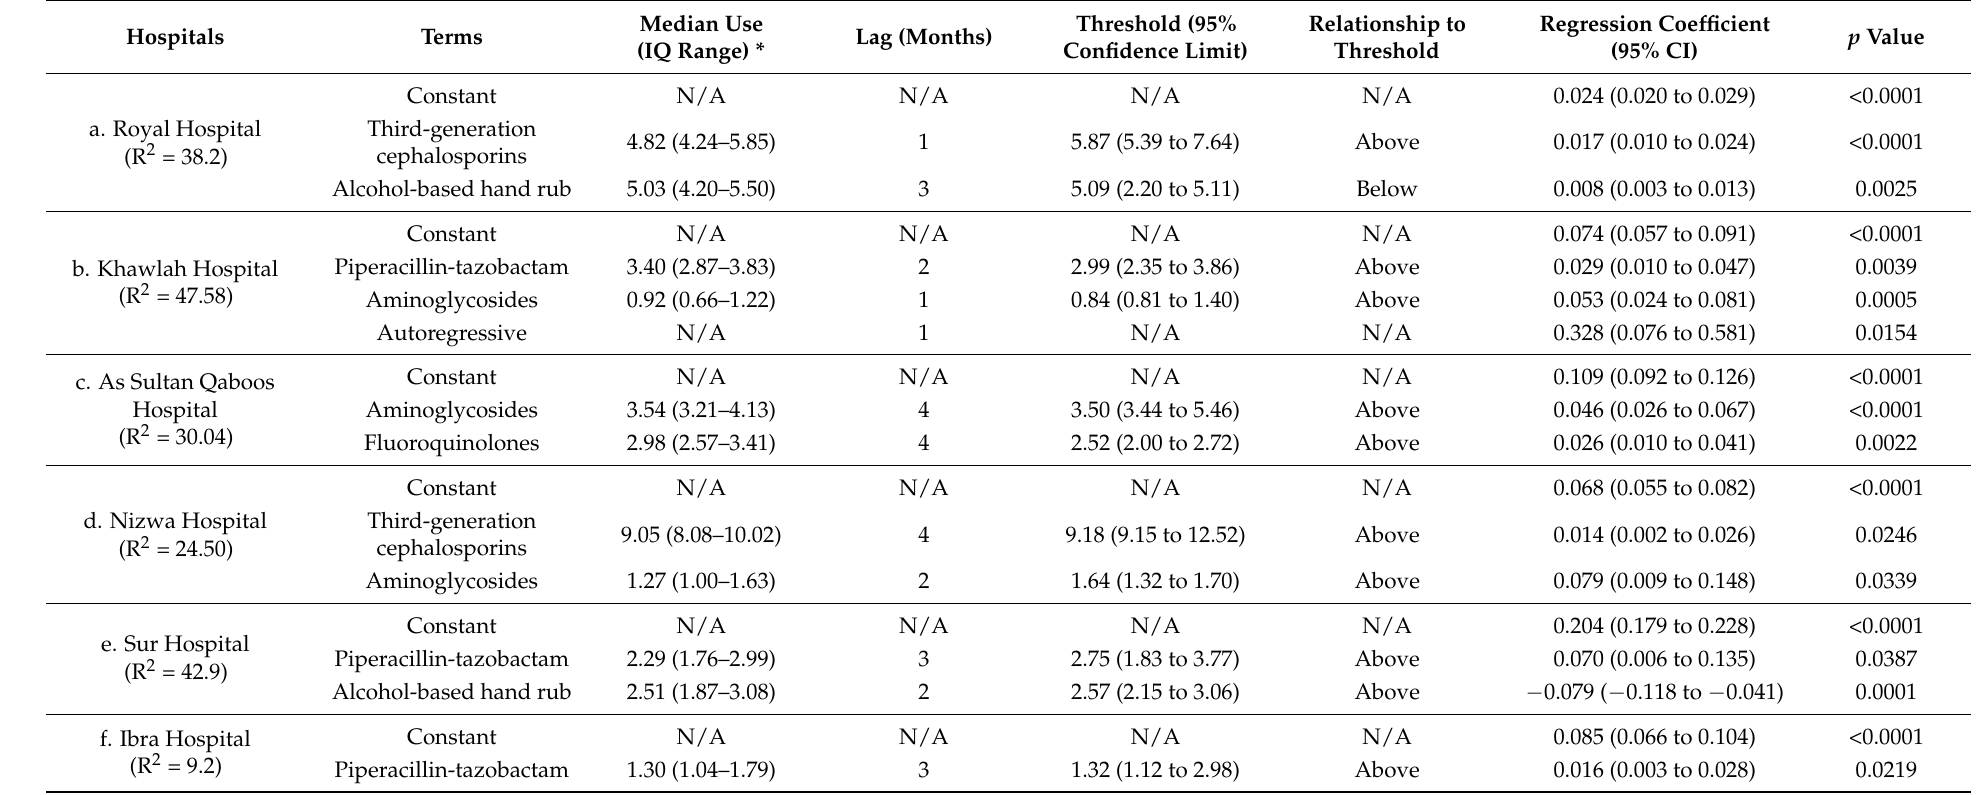
Table 1. Results of multivariable non-linear time-series analyses, January 2015 to December